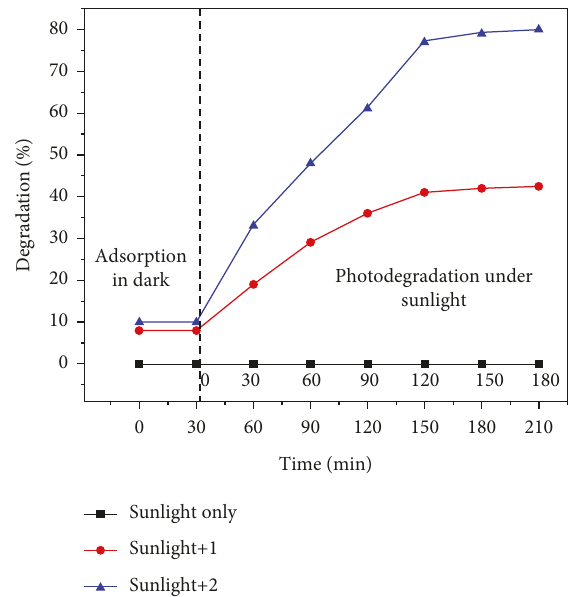
Figure 9: Degradation efficiencies of complexes (1) and (2) against Congo red under solar light irradiation.